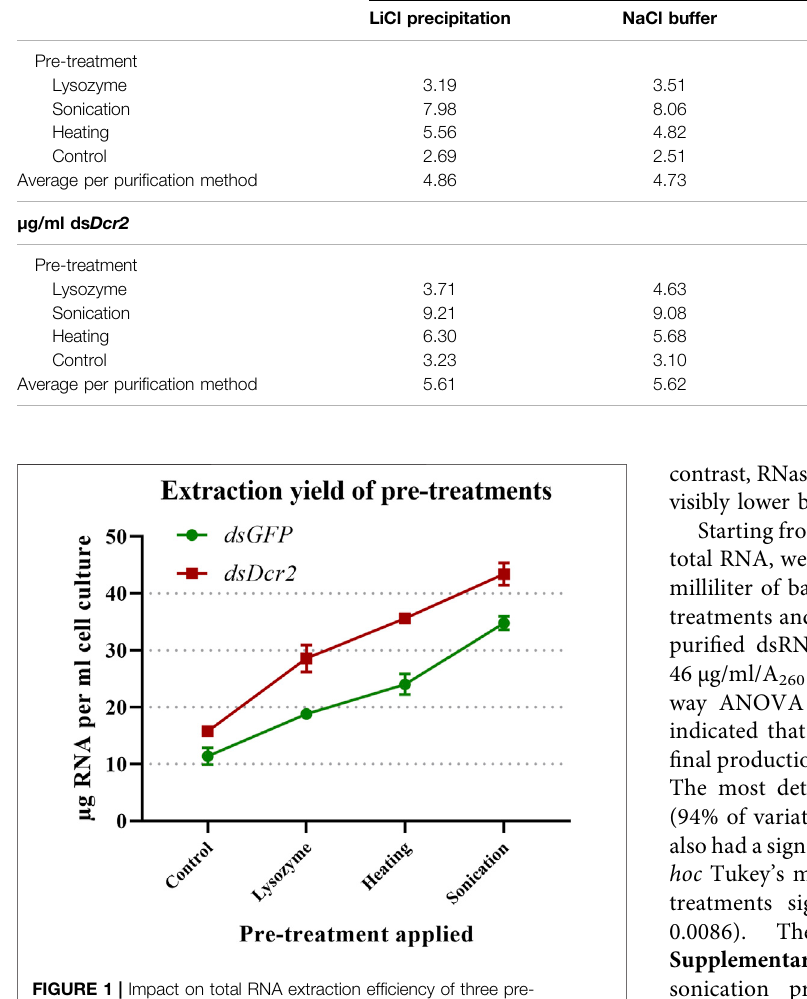
Frontiers in Physiology |